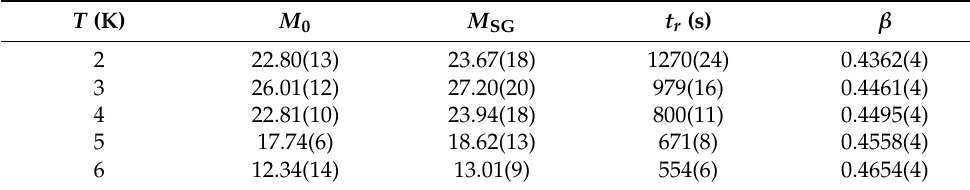
Table 3. The most important parameter is the mean relaxation time, t r , and it decreases monotonically with increasing temperature. Table 3. Results of the fittings of the relaxation curves of Sm 2 CuMn(MnTi 3 )O 12 at different